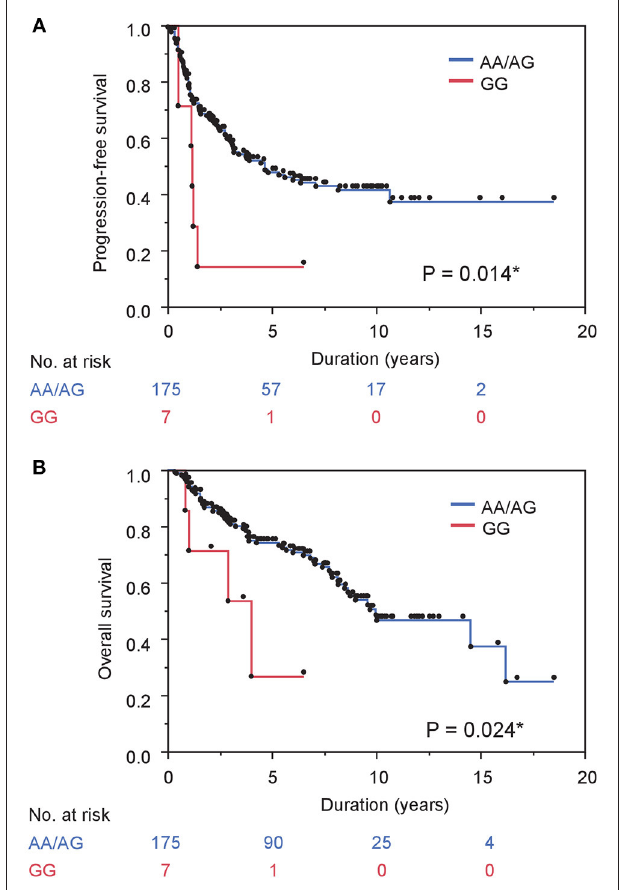
FIGURE 1 | Gene polymorphism in MR rs5522 correlates with survival in prostate cancer cases treated with ADT. (A) and (B) PFS (A) and OS (B) stratified by gene polymorphism in MR rs5522 are shown.